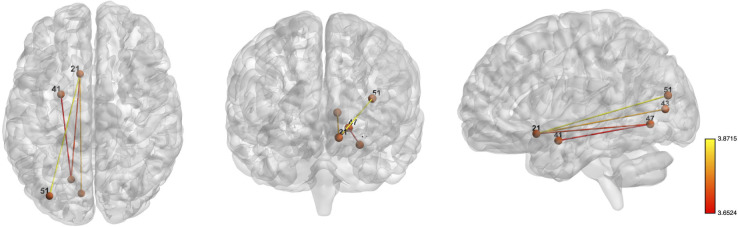
Whole-brain networks with increased structural connectivity in high adherence MedDiet group. Whole-brain networks with increased structural connectivity in high-adherence MedDiet group (when compared to the low-adherence MedDiet group), with p < 0.0005. High adherence to the MedDiet had higher SC in a network with the following regions: left olfactory cortex, left amygdala, left calcarine, left lingual gyrus, and left middle occipital gyrus. Color scheme: higher connectivity from red to yellow. The analyses were controlled for age, sex, years of education, and BMI. Numbers’ legend: (21) left olfactory cortex, (41) left amygdala, (43) left calcarine, (47) left lingual gyrus, and (51) left middle occipital gyrus.